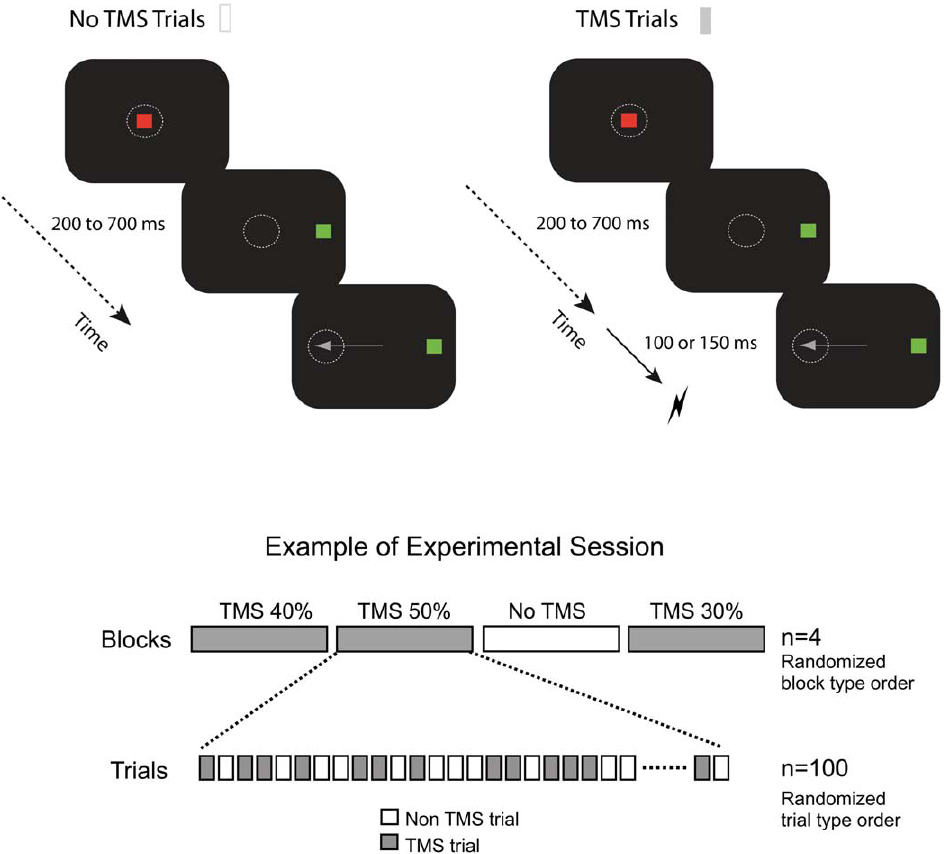
Figure 1. Behavioral paradigm illustrating the experimental antisaccade paradigm. ( Upper panel) Antisaccade paradigm practiced by the two monkeys under the online impact of sham (left panel) or active (right panel) TMS single pulses. After fixating on a central stimulus (red), monkeys were to initiate a fast saccade to a location in the opposite direction with respect to a peripheral target (green) appearing on the screen, simultaneously (no gap) to the disappearance of the central fixation. Animals performed within each block, no-TMS trials (white small rectangles) yielding no stimulation at all (Upper Left) and TMS trials (grey small rectangles) during which a single TMS pulse was delivered at a given postarget onset SOA prior to the AS initiation, to modulate the planning of visually guided oculomotor activity (Bottom panel) Example of an experimental session. Animals performed a total of 4 blocks of AS training per session. In one of the blocks they did not receive TMS (white long rectangle), whereas in the remaining 3, they received in half of the trials TMS pulses (see long grey-filled rectangles) at one of the 3 intensities used in the study (30%, 40% and 50%). The order of the four blocks (3 TMS blocks at 30%, 40% or 50% absolute TMS intensities and 1 noTMS block) was randomized within each session. Monkeys performed 100 trials per block (50 no-TMS and 50 TMS trials) for a total of 400 trials per session, and received 50 pulses per TMS block (i.e., only in 50% of the trials), amounting to 150 pulses per experimental session. Independent sessions comprising active TMS pulses delivered at 100 ms or 150 ms SOA post target onset on the FEF, sham TMS pulses and active TMS stimulation in a control location were carried over.